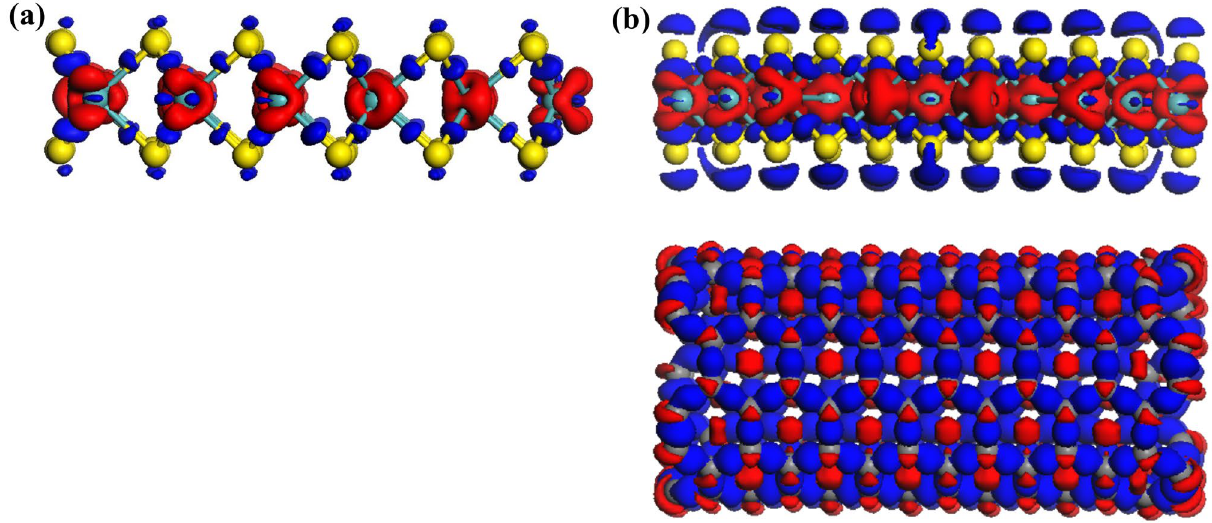
Figure 4. Spatial mapping of charge density differences for: ( a ) a MoS 2 monolayer; and ( b ) the MoS 2 /CNT heterostructure. Regions of electron accumulation and depletion are denoted by blue and red lobes,